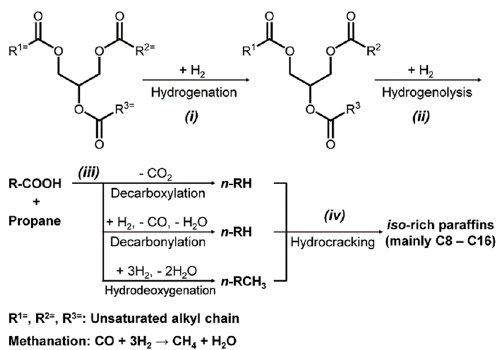
Figure 1. Reaction pathways of the hydroconversion of tryglycerides into biojet fuel.